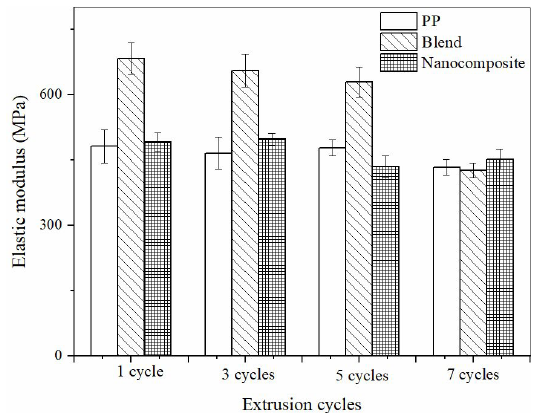
Figure 7. Elastic